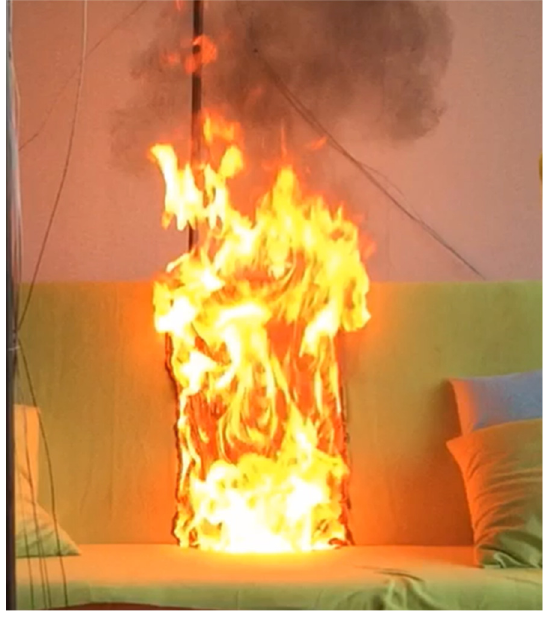
Figure 14. An image of u-shaped burning region (about 493 s of the first fire test).